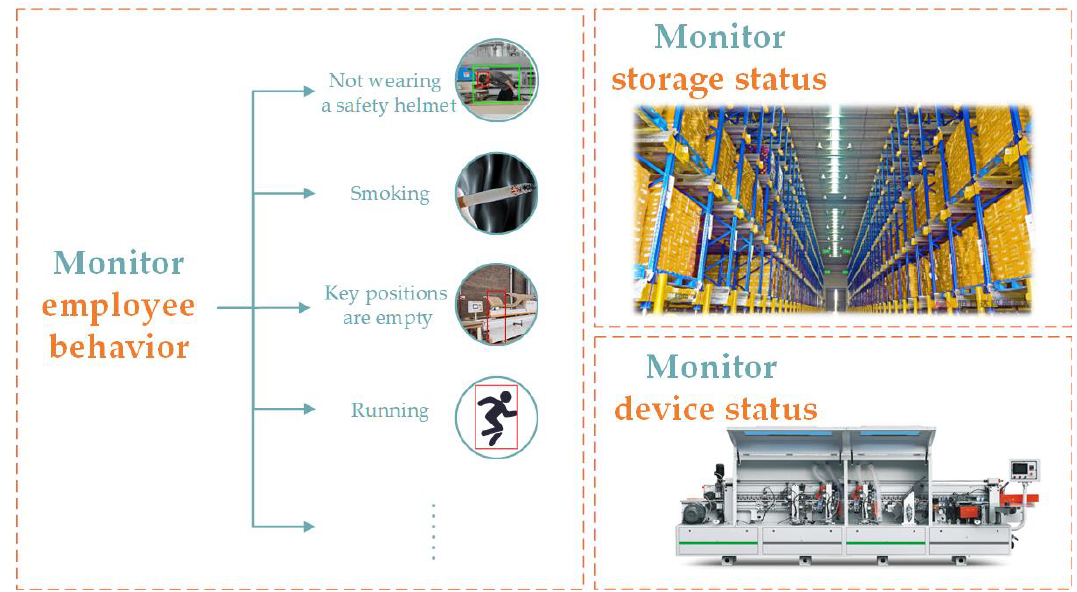
Figure 6. Application of intelligent monitoring.